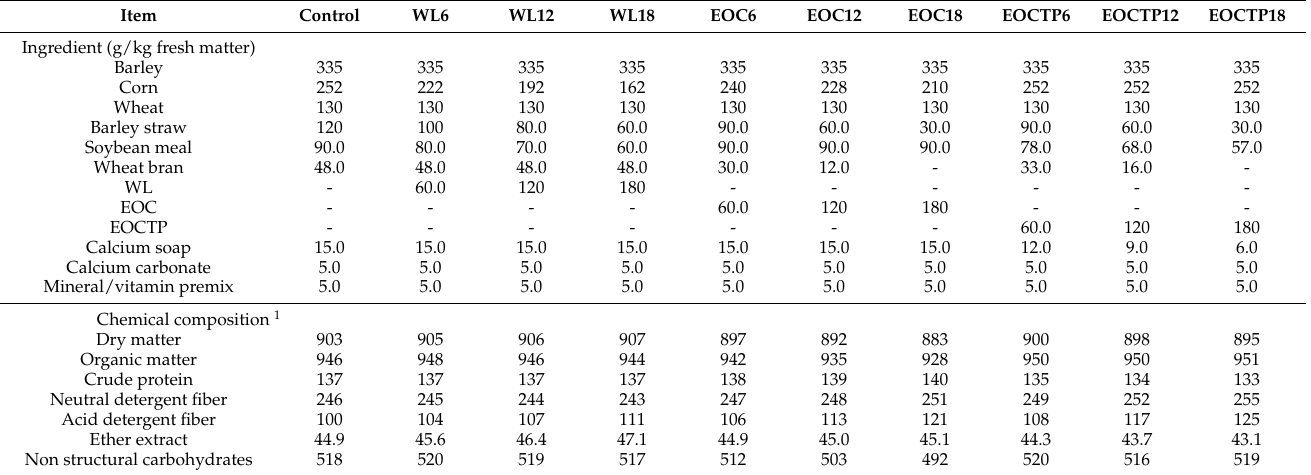
Table 2. Ingredients and chemical composition of experimental diets containing increasing quantities (0 (Control), 6, 12 and 18%; fresh matter basis) of wine lees (WL), exhausted olive cake (EOC), or a 1:1 mixture of EOC and tomato pomace